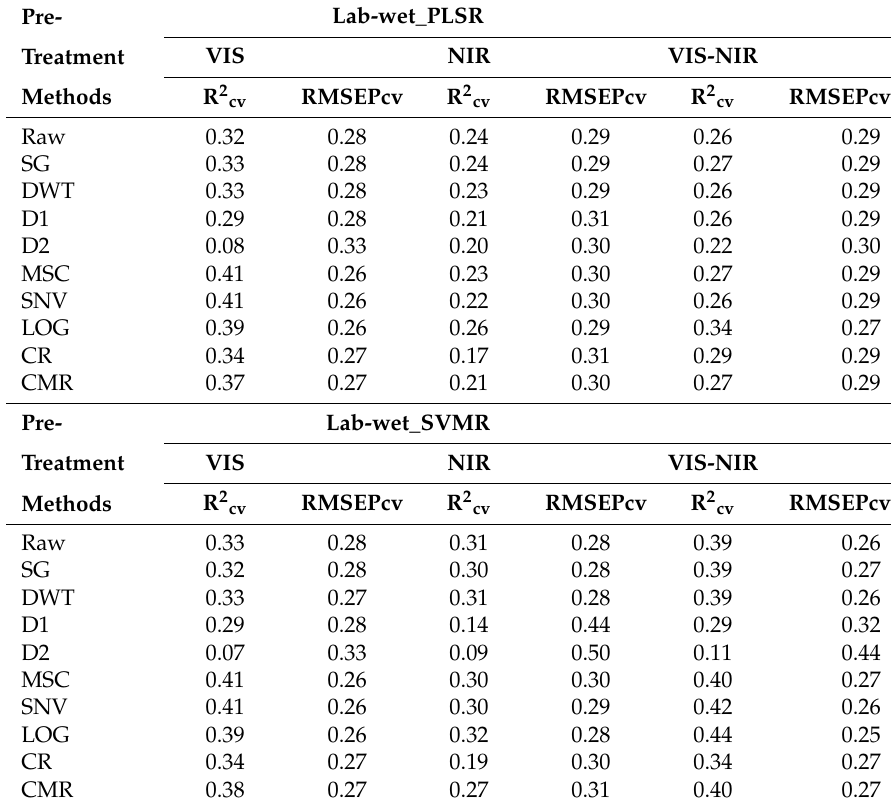
Table 3. Statistics of the five fold leave-group-out cross validation for lab wet spectra using both PLSR and SVMR on di ff erent preprocessing methods. The results were calculated as mean values from one hundred independent leave-group-out cross-validation